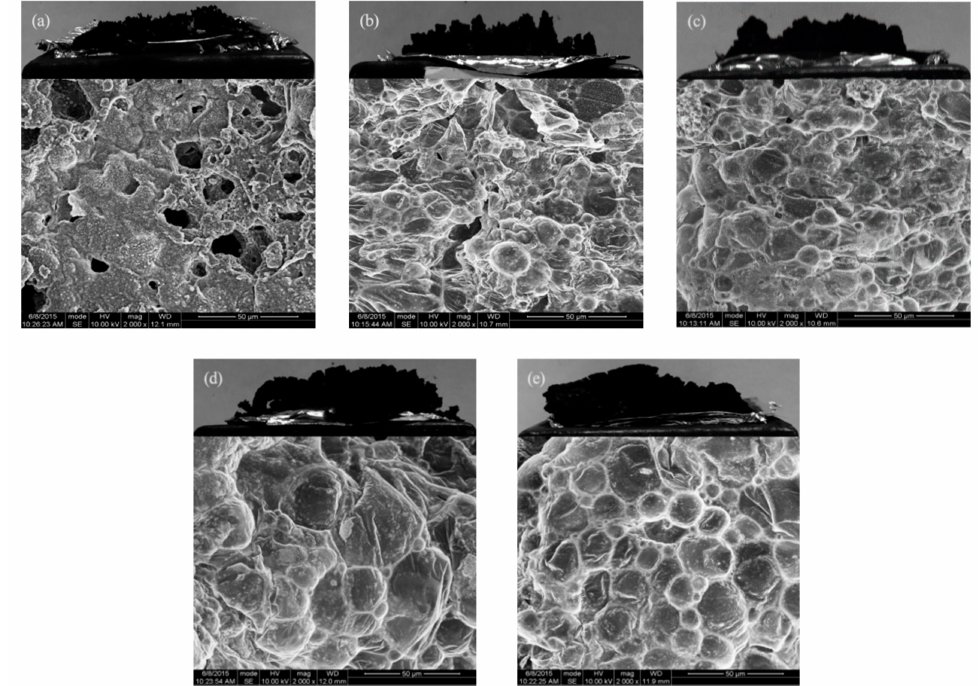
Figure 8. Morphology of burnt composites ( a ) NR; ( b ) NR/IFR; ( c ) NR/IFR/MCM-41; ( d ) NR/IFR/GO; ( e ) NR/IFR/GO-NH-MCM-41.